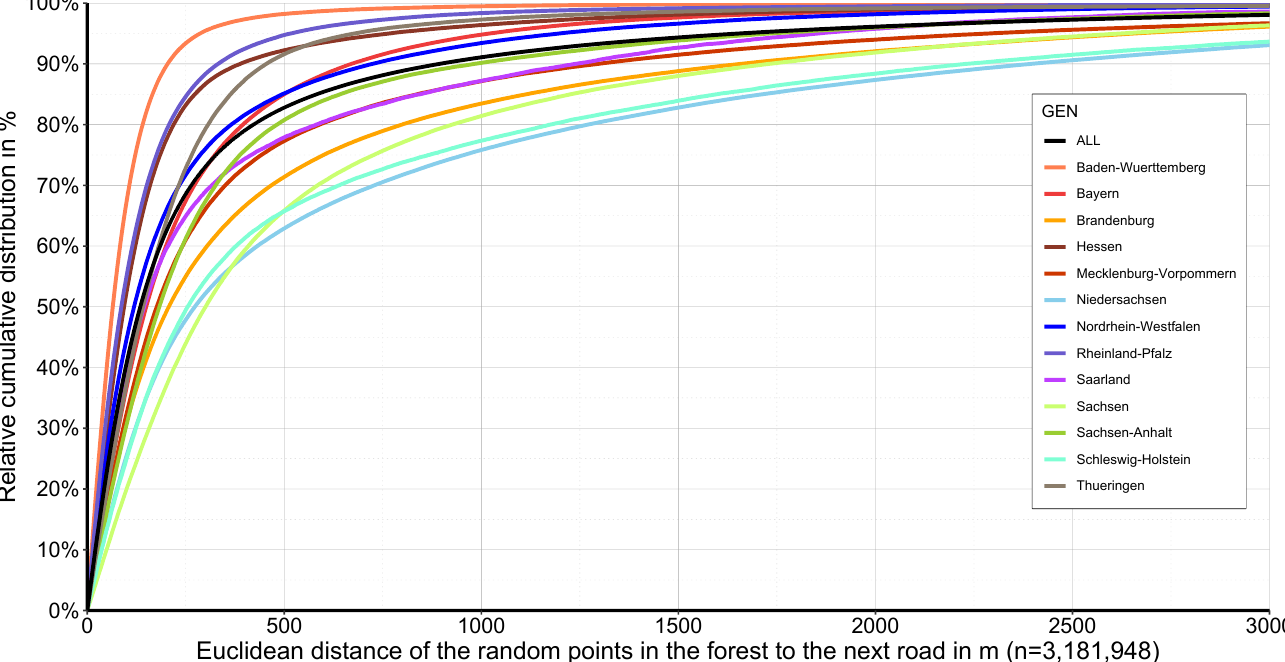
Figure 7. Relative cumulative distribution of the Euclidean distance from random points in the forest to the nearest NavLog or public road for the different federal states and the federal